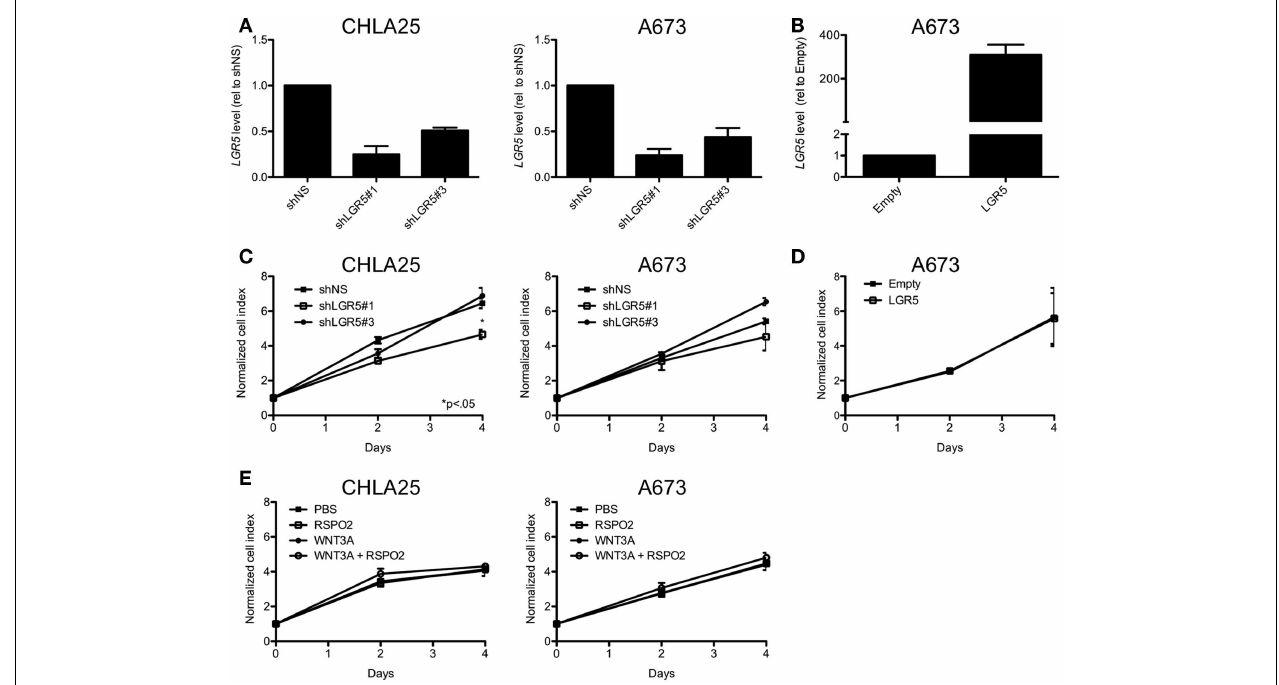
FIGURE 7 | Leucine-rich repeat-containing G-protein coupled receptor 5 does not promote ES cell proliferation. (A) qRT-PCR confirmation of LGR5 knockdown in ES cell lines transduced with LGR5 -targeted shRNAs (shNS = non-silencing control). (B) Confirmation of LGR5 over-expression in A673 cells transduced with LGR5 over-expression construct (Empty,